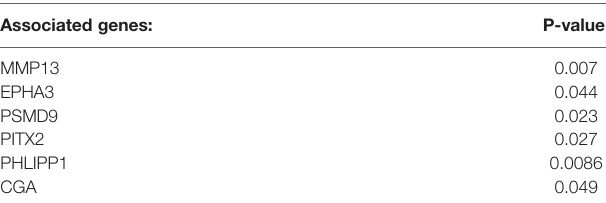
TABLE 1 | Genes associated with poor therapy outcome after chemotherapy (p < 0.05).